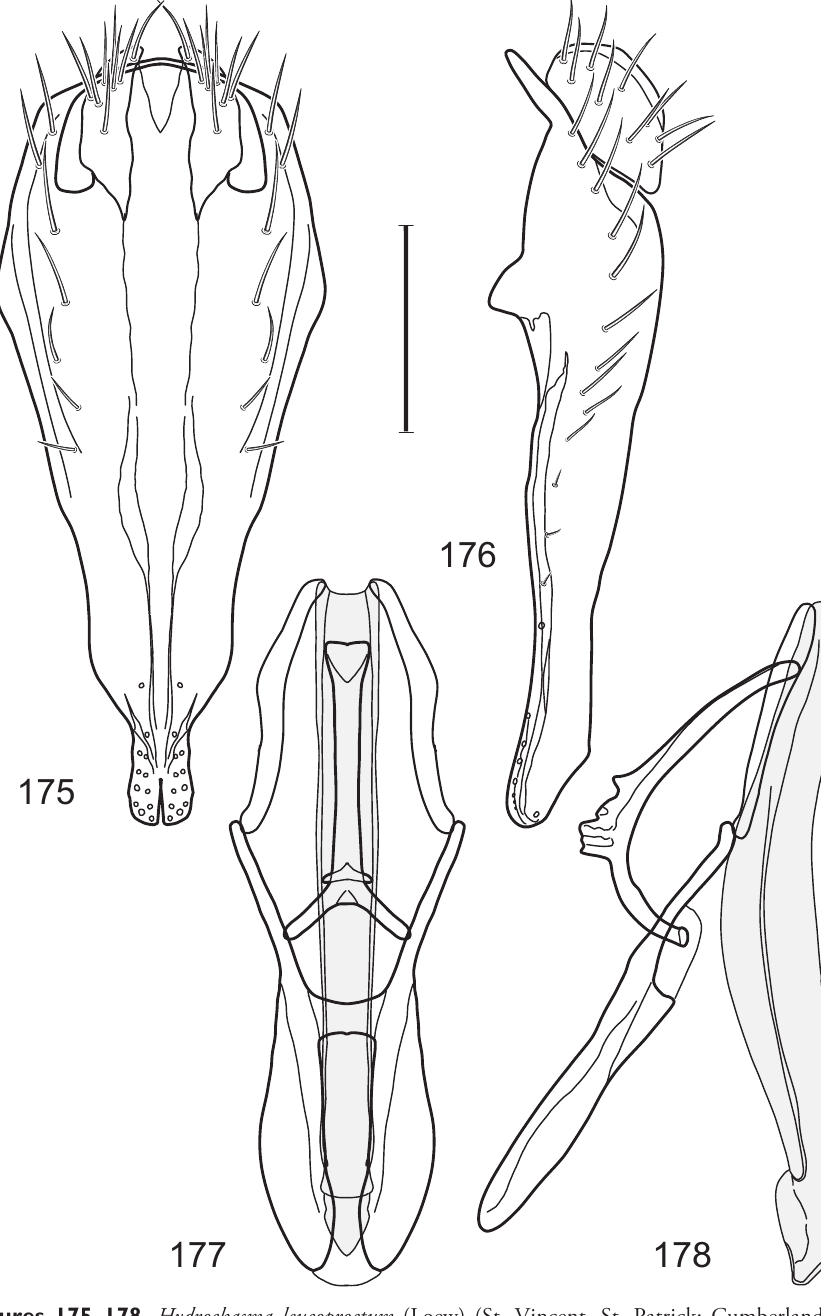
Figures 175–178. Hydrochasma leucoproctum (Loew) (St. Vincent. St. Patrick: Cumberland Bay) 175 epandrium and cerci, posterior view 176 same, lateral view 177 internal structures of male ter- minalia (aedeagus [shaded], phallapodeme, gonite, hypandrium), ventral view 178 same, lateral view. Scale bar = 0.1